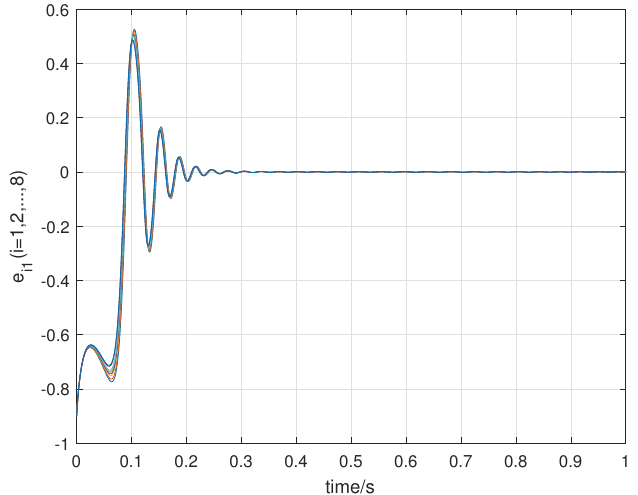
Figure 2. Trajectories of synchronization errors e j 1 ( 1 ≤ j ≤ 8 ) for the complex networks (70) and (73) with eight fractional order nodes with time variance.